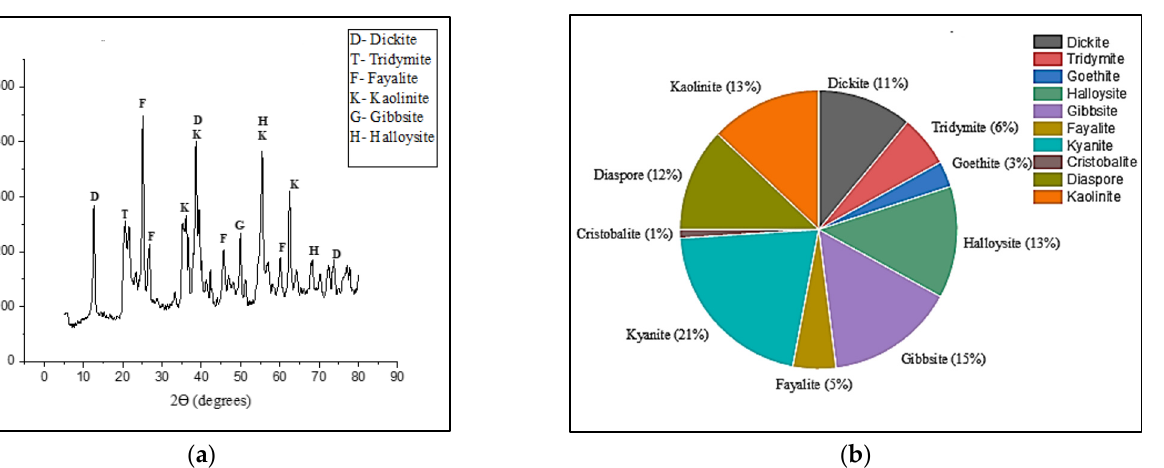
Figure 20. Characterization of minerals and compounds; ( a ) XRD analysis of Nagoor sample, ( b ) quantification of compounds.